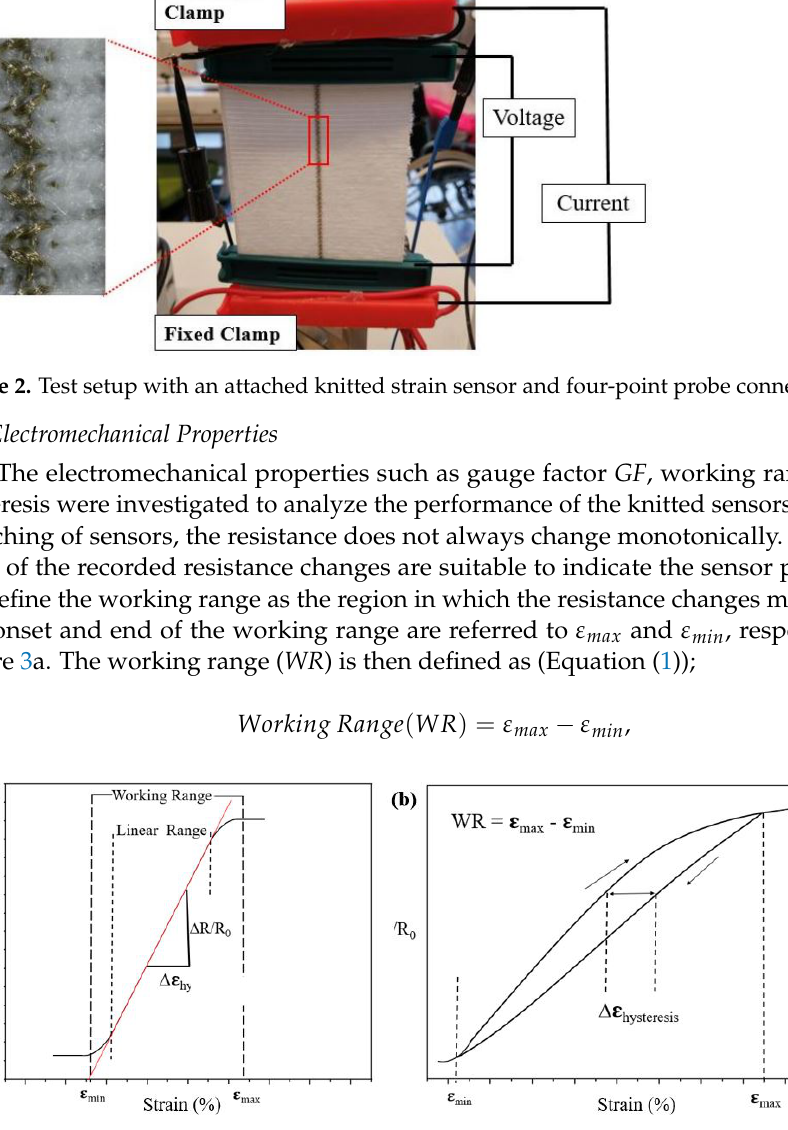
Figure 3. ( a ) A graph showing how to calculate the gauge factor and working range, and ( b ) A graph showing how to calculate the resistance hysteresis (Black arrows represent the loading and unloading during a